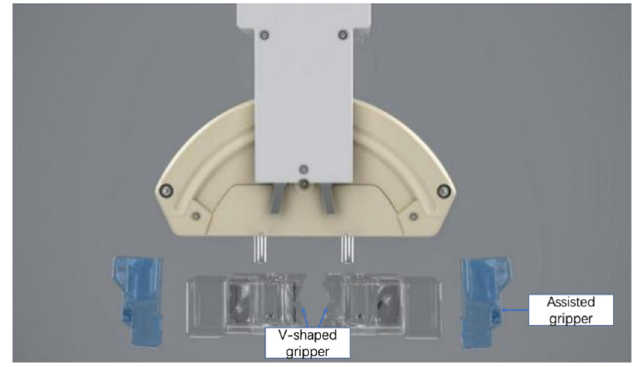
Figure 5. Detachable design of the